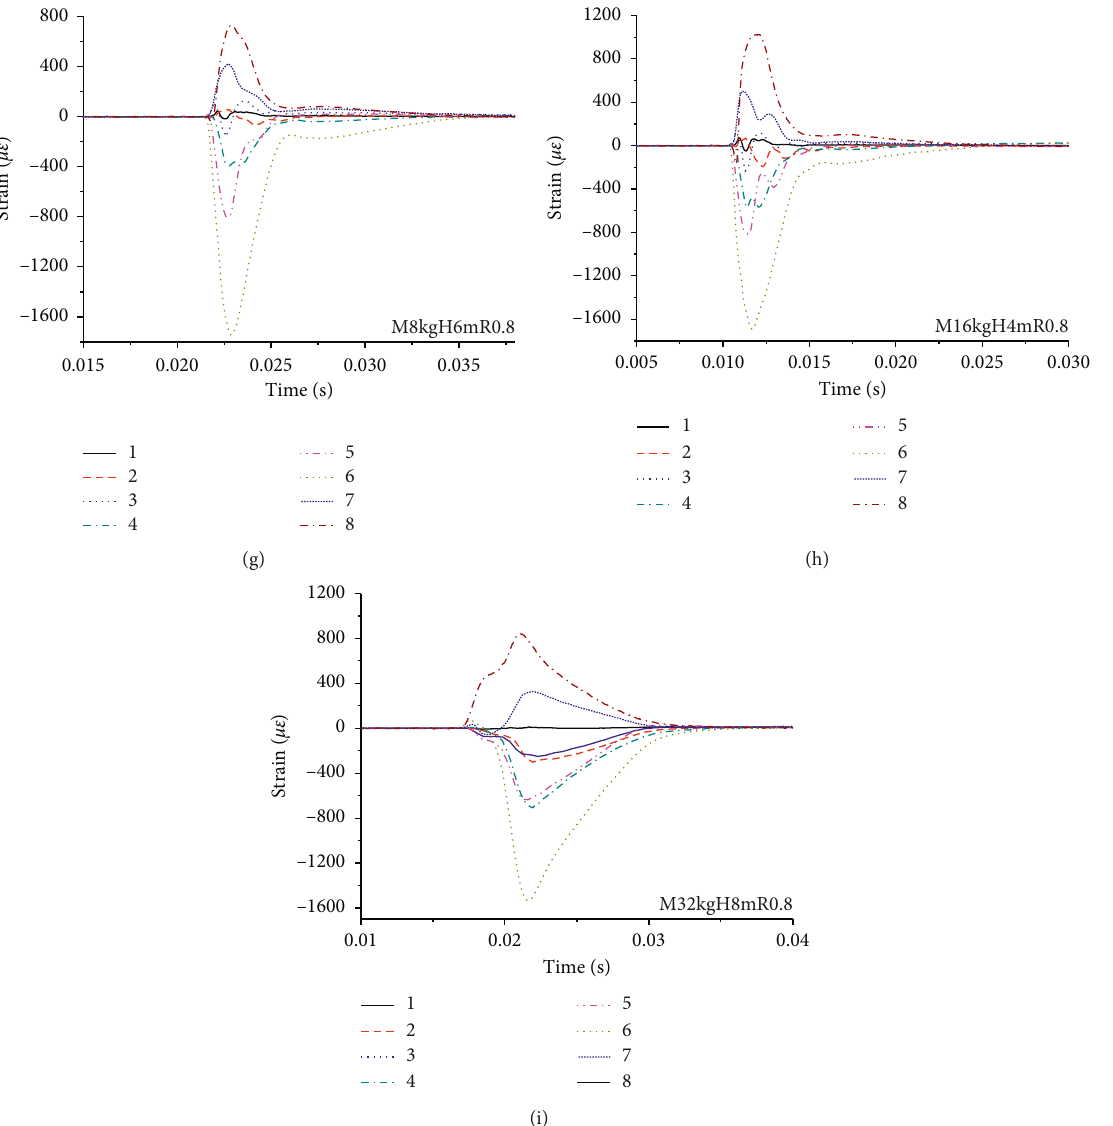
Figure 4: Strain curves of each measured point. (a) Condition 1. (b) Condition 2. (c) Condition 3. (d) Condition 4. (e) Condition 5. (f) Condition 6. (h) Condition 7. (i) Condition 8. (j) Condition